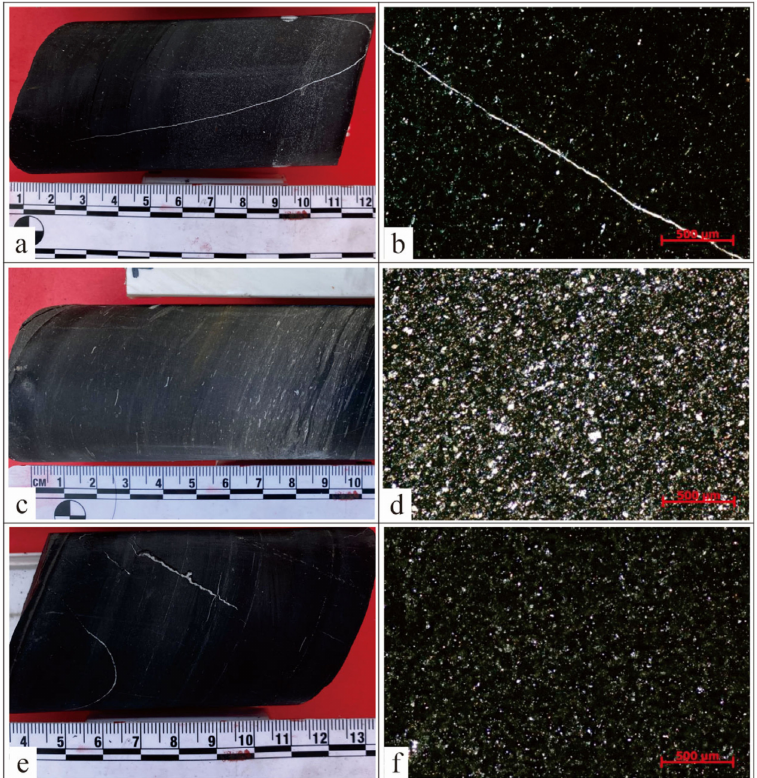
Figure 5. Characteristics of ( a , b ) Siliceous rock, ( c , d ) Carbonate-rich siliceous shale, and ( e , f ) Clay- rich siliceous shale from well ED-2. ( a ) Photograph of black siliceous rock from 1232.9 m depth. ( b ) Microphotograph of black siliceous rock from 1233.1 m depth, rich in organic matter and con- tains calcite-filled fractures. ( c ) Gray-black carbonate-rich siliceous shale from 1221.9 m depth. ( d ) Microphotograph of carbonate-rich siliceous shale from 1222.2 m depth, with calcite, quartz, and organic matter distributed throughout. ( e ) Black clay-rich siliceous shale from 1242.0 m depth. ( f ) Microphotograph of clay-rich siliceous shale from 1242.2 m depth, rich in organic matter.